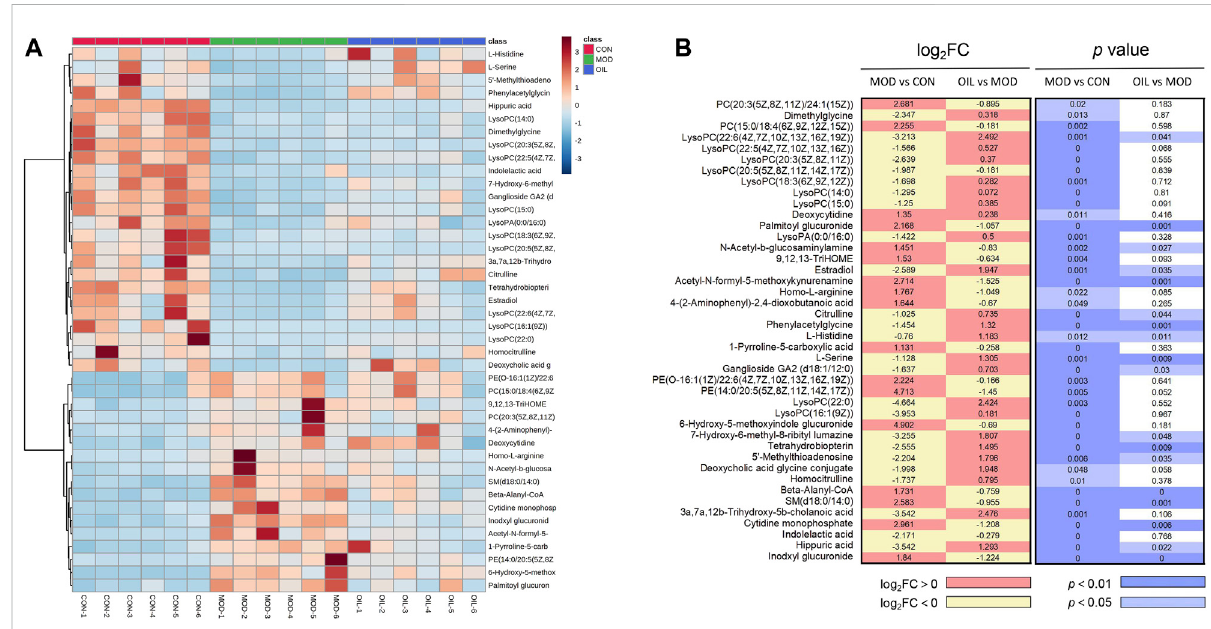
FIGURE 4 Heat map of the differentially abundant metabolites in all groups (A) . The degree of colour saturation indicates the metabolite expression with blue and red respectively indicating the lowest and highest expression. p -Value heat map of the differential abundance of metabolites in all groups (B) . The degree of colour saturation indicates intergroup differences in metabolite expression values with white and blue indicating non-signi fi cant and signi fi cant differences, and pink and yellow indicating upregulation and downregulation,